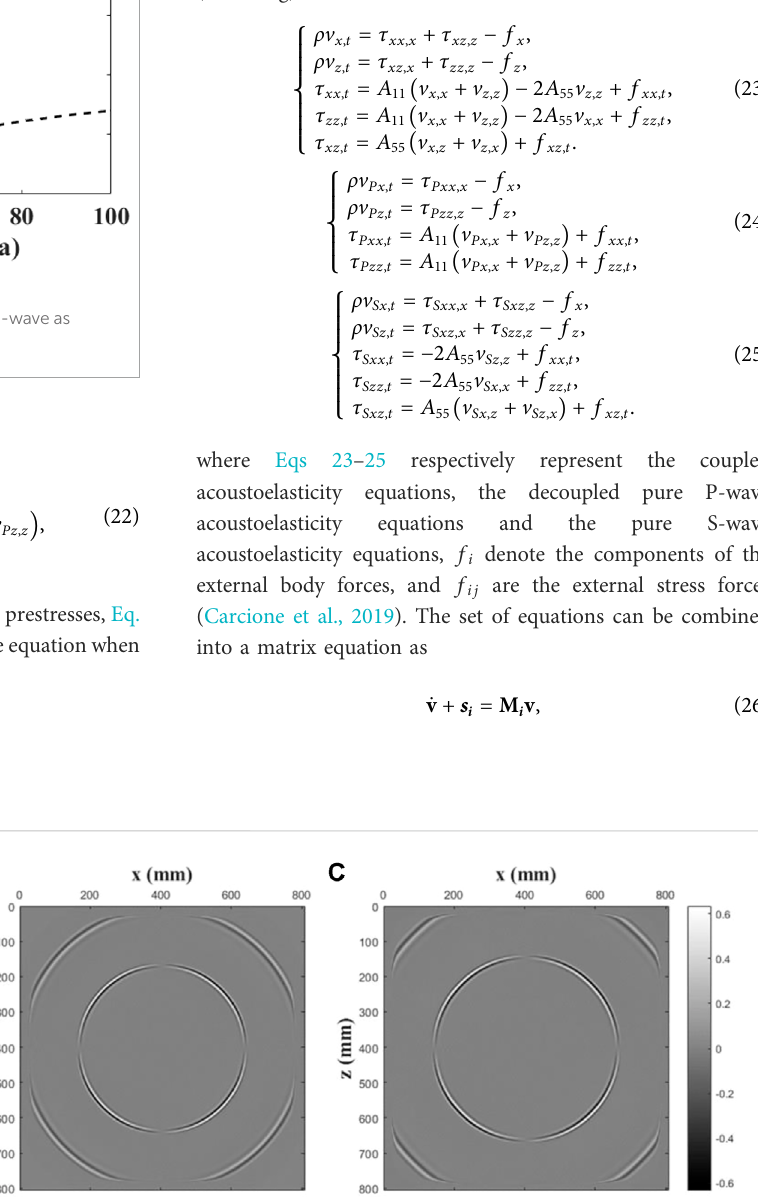
Frontiers in Earth